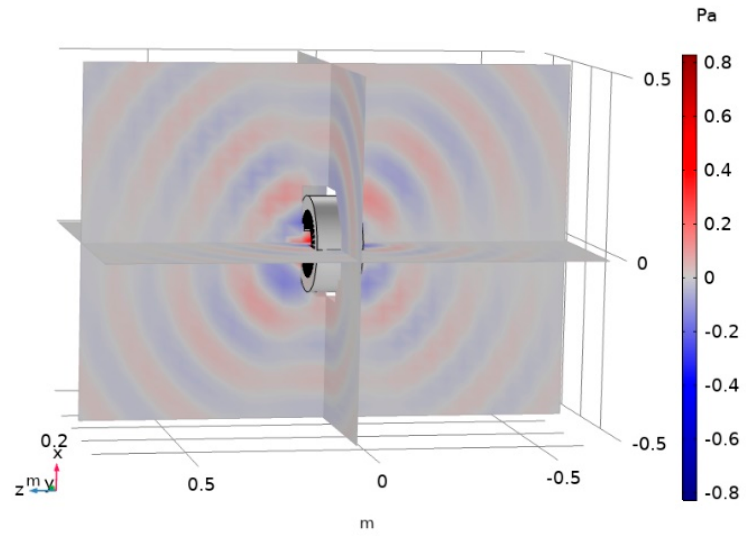
Figure 7. Acoustic pressure distribution in Pa outside the motor at 2016 Hz.